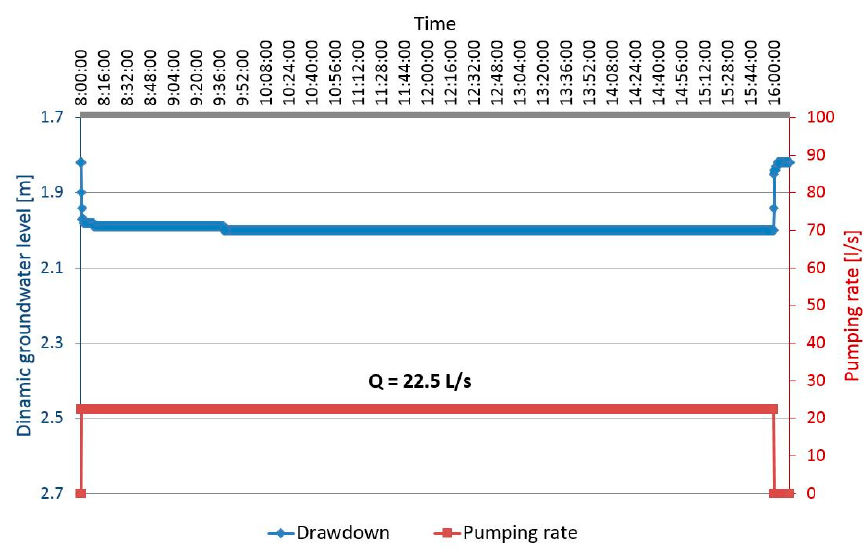
Figure 13. Drawdown in the pumping well Z-1 for constant test.